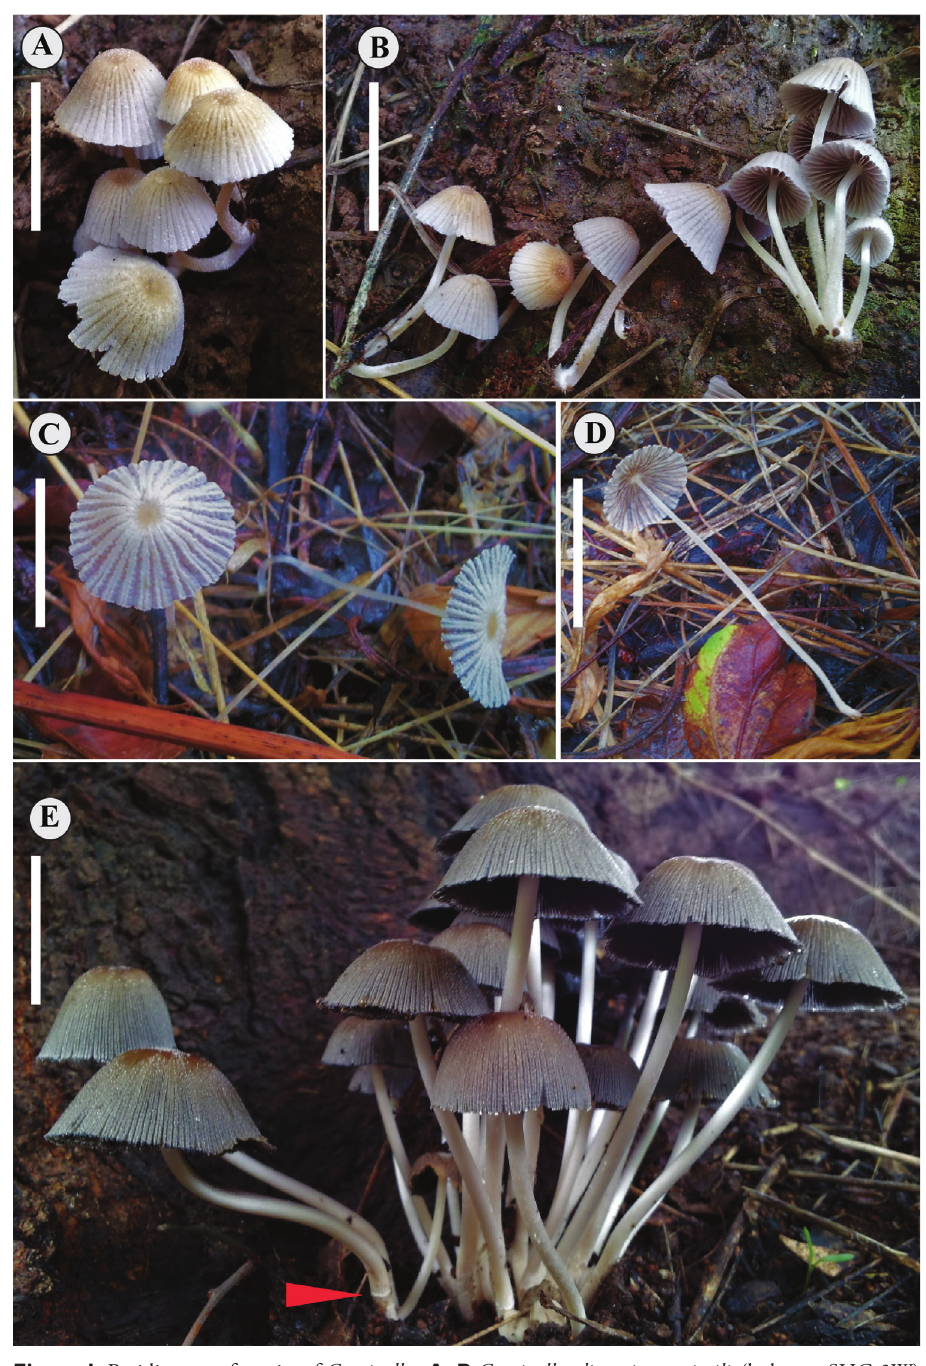
Figure 1. Basidiomata of species of Coprinellus . A–B Coprinellus disseminates-similis (holotype SHCr3W) C–D Coprinellus tenuis (holotype SHP10) E Coprinellus campanulatus (holotype SH144). The arrow shows remnants of membranous annulus. Scale bars: 20